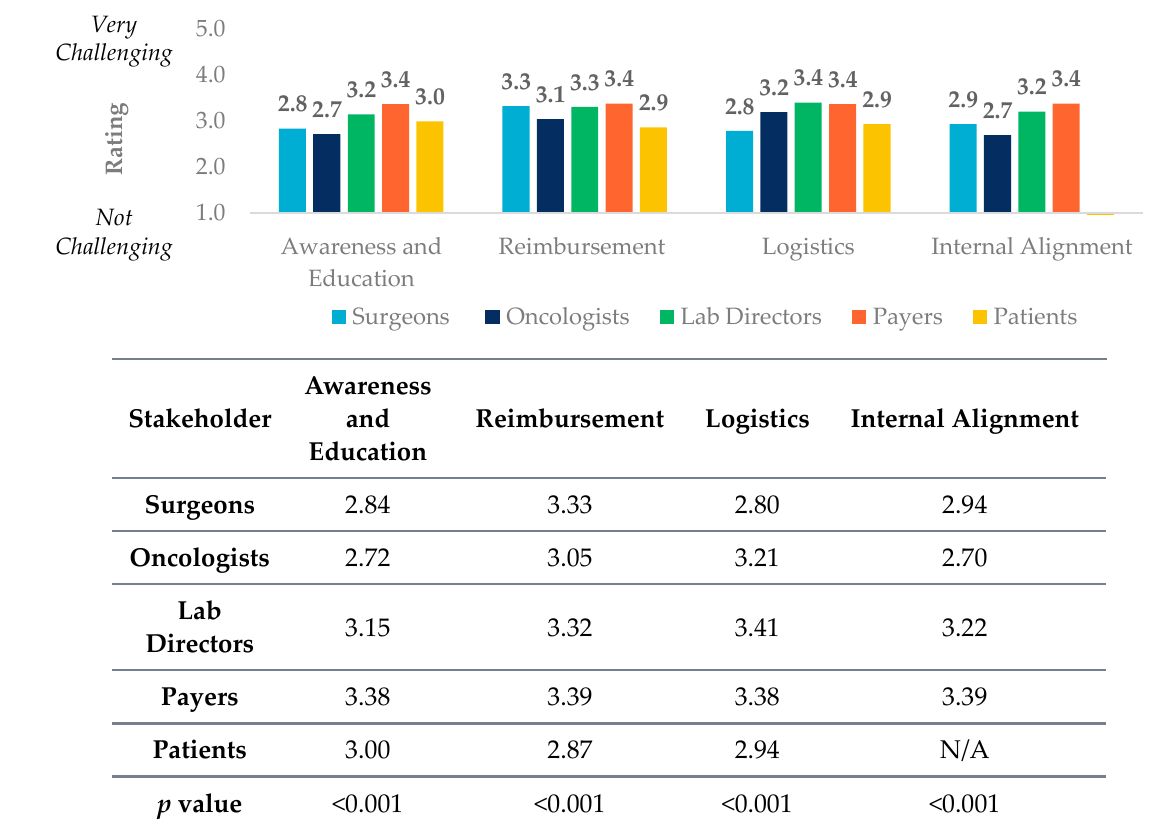
Figure 1. Lab directors, oncologists, surgeons, payers, and patients ( n = 653) were asked the following question with different responses. Please rate how challenging the following factors are to biomarker testing for oncology targeted therapies on a scale of 1 to 5, where 1 is not challenging and 5 is very challenging. Responses were then clustered together in constructs around four different themes of awareness and education, reimbursement, logistics, and internal alignment. The average responses between respondents were found to be statistically significantly different ( p value ≤ 0.001) for all constructs. Statistical analysis was done using a one-way ANOVA. Construct definitions can be found in methods.